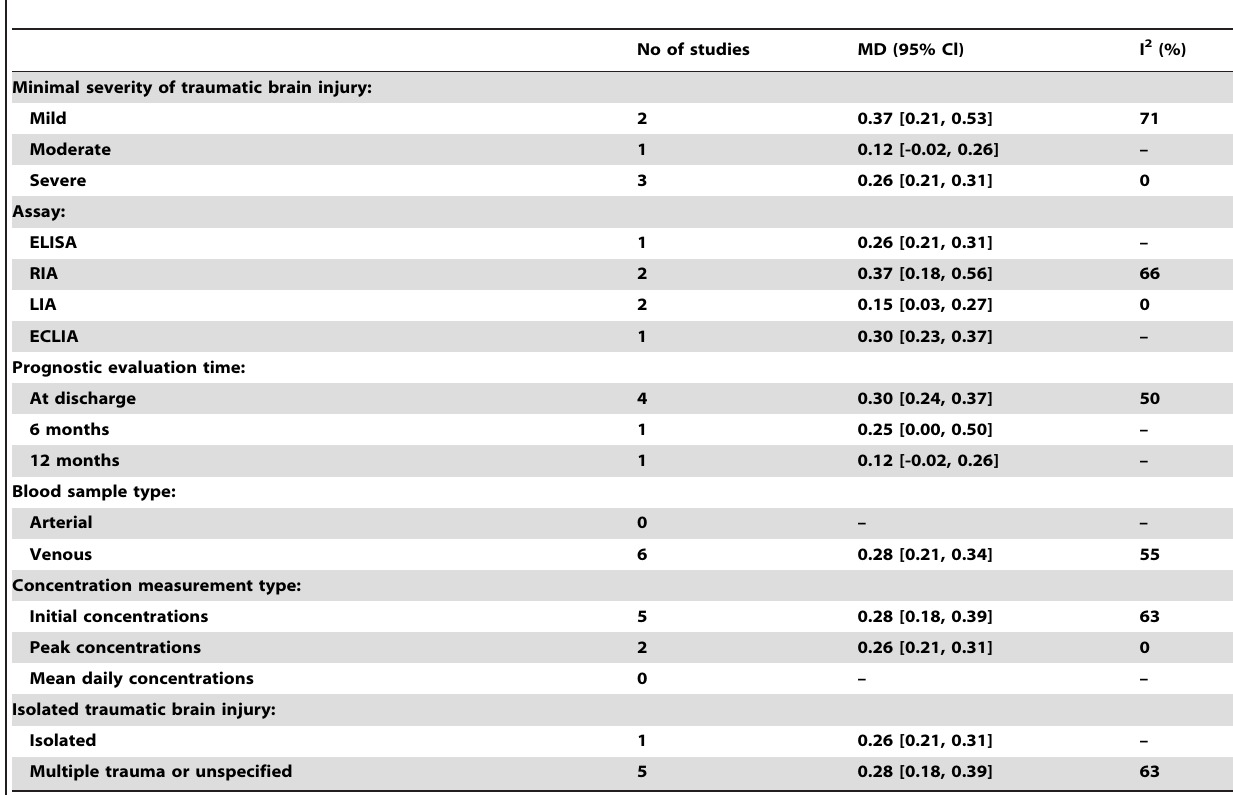
Table 2. Sensitivity analyses for association of NSE concentrations with mortality in patients with traumatic brain injury.